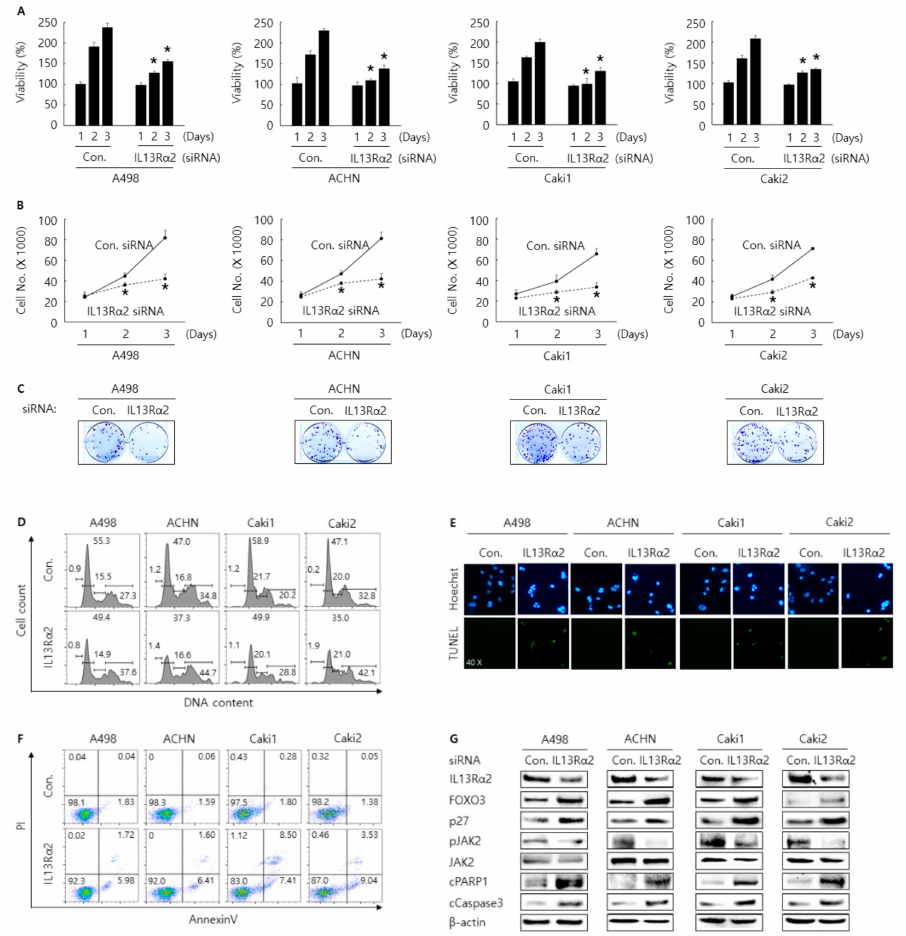
Figure 3. Antiproliferative effect by transfection of siRNA against IL13R α 2 in A498, ACHN, Caki1, and Caki2 cells. Cell viability and proliferation rate were determined by WST-1 ( A ), cell counting assay ( B ) for 24, 48, and 72 h, and Colony formation assay for 14 days ( C ). This result is representative data of at least three independent experiments, and the error bar indicates mean ± standard error (STE). * stands for the P- value < 0.05. Cell cycle arrest for 48 h after transfection was determined by cell cycle analysis ( D ). Apoptosis for 48 h after transfection was determined by Annexin V staining analysis ( E ) and Terminal deoxynucleotidyl transferase dUTP nick end labeling (TUNEL) assay ( F ). This result represents at least three independent experiments ( G ) Western blotting analysis of proteins related to cell cycle arrest and apoptosis for 48 h after transfection. β -actin was used for a gel-loading